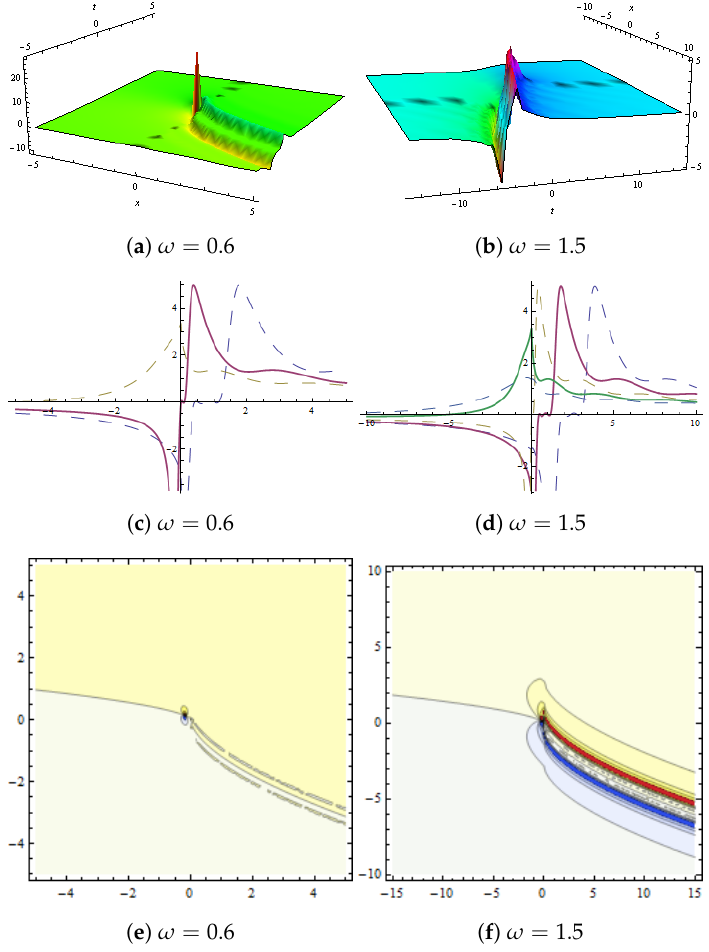
Figure 18. Dynamical behaviour of v ( x , t ) in Equation (45) represented via β 1 = 0.3, β 2 = 0.2, β 3 = 0.5, β 4 = 0.04, ζ = 0, l 2 = 0.01, l 5 = 0.5, Q = 1.2, r 1 = 2.5, w 2 = 0.02, w 3 = 3.1, and φ = 1.4. ( a , b ) show 3D graph of lump wave, ( c , d ) represent 2D graph and ( e , f ) show contour plot for different values of ω .